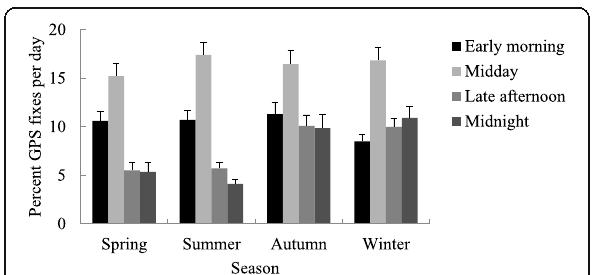
Fig. 7 Percentage and standard error of GPS fixes inside shade patches per day of a free-ranging cattle herd ( N = 11) for each season and during four 3-h time periods (early morning, midday, late afternoon, and midnight), by using positional data from eight trials of 3 weeks from September 2007 to August 2008 in a semi-arid rangeland in South Texas, USA